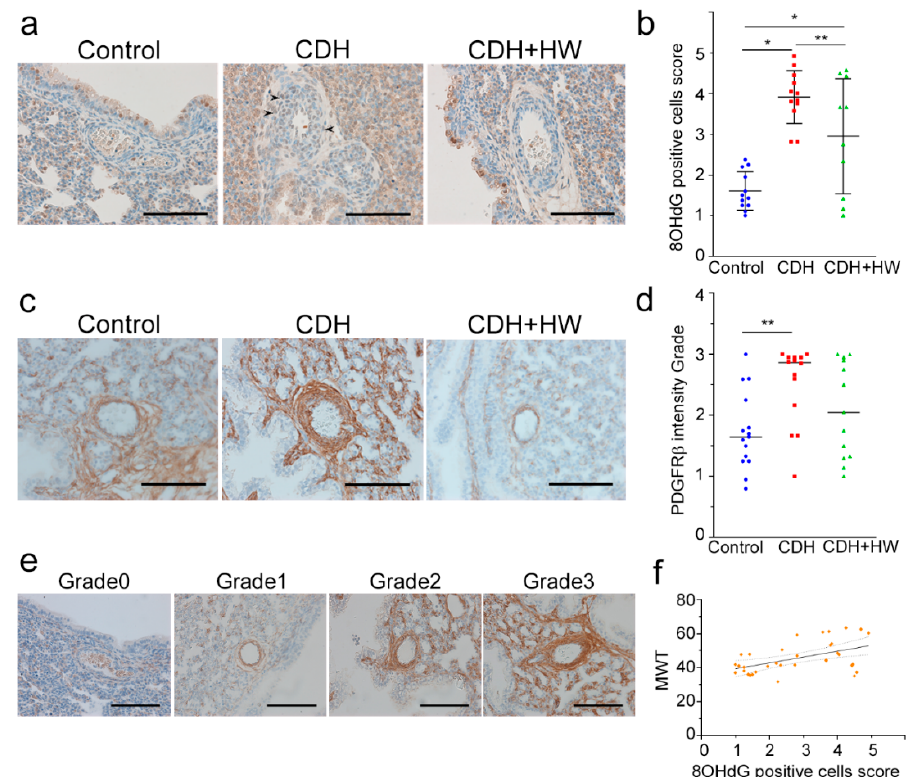
Figure 3. Expression of 8-hydroxy-2 ′ -deoxyguanosine (8-OHdG) and platelet-derived growth factor receptor-beta (PDGFR β ) in pulmonary arteries. ( a ) Representative immunohistochemistry images of the pulmonary artery for 8-OHdG. The 8-OHdG positive cells are indicated by arrowheads. Original magnification, 400 × . Scale bars = 100 µ m; ( b ) The ratio of 8-OHdG positive cells to arterial wall cells was scored as follows, 1, 0–5%; 2, 5–25%; 3, 25–50%; 4, 50–75%; 5, 75–100%. The bars indicate the mean ± standard deviation. Pulmonary arterial walls in CDH showed significantly more 8-OHdG positive cells than in the control ( n = 12); 8-OHdG positive cells were less in CDH+ hydrogen-rich water (HW, n = 10) than in CDH ( n = 12); ( c ) Representative immunohistochemistry images of the pulmonary artery for PDGFR β . Original magnification, 400X. Scale bars = 100 µ m; ( d ) The grades of pulmonary artery immunohistochemical staining intensity for PDGFR β are shown in the control ( n = 15), CDH ( n = 14), and CDH + HW ( n = 13) groups. The bars indicate the median; ( e ) The grades 0–3 were defined as shown. Original magnification, 400X. Scale bars = 100 μ m; ( f ) MWT showed a significantly positive correlation with 8-OHdG positive cells score ( p < 0.01 , ρ = 0.441). Values are expressed as means (solid lines), and 95% confidence bands (dotted lines). * p < 0.01, ** p < 0.05.